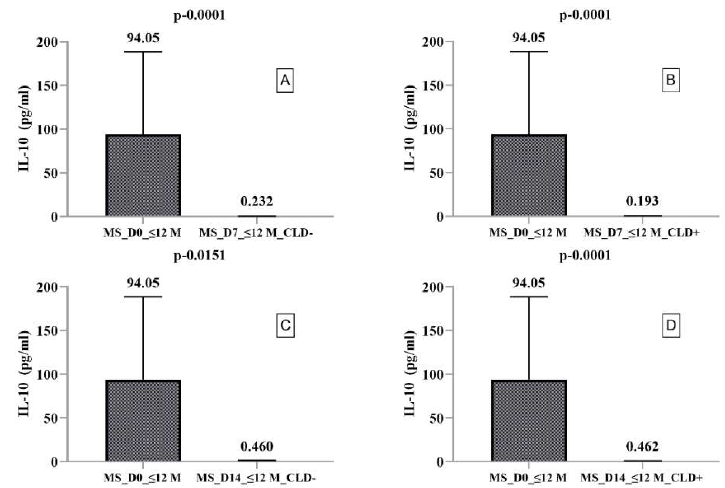
Figure 1. Boxplot type diagrams through which we followed the medians and interquartile range. Median values and statistical significance are mentioned in the graph. Comparison of CLD exposure